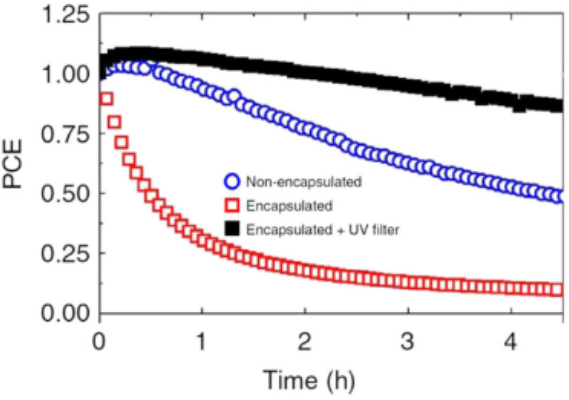
Figure 8: The effect of the encapsulation and UV filter on the Per- ovskite solar cells degradation [21]